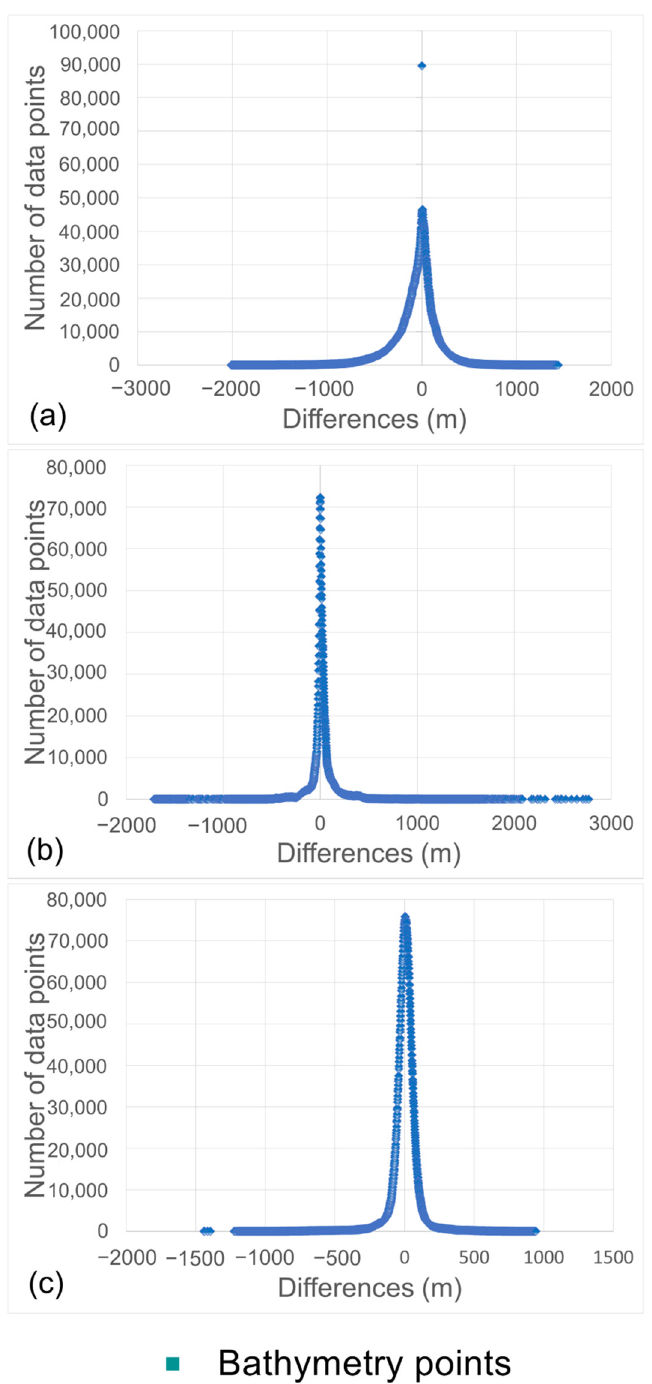
Figure 8. Differences between corrected and truth values in ( a ) West Pacific, ( b ) Southern Ocean, and ( c ) East